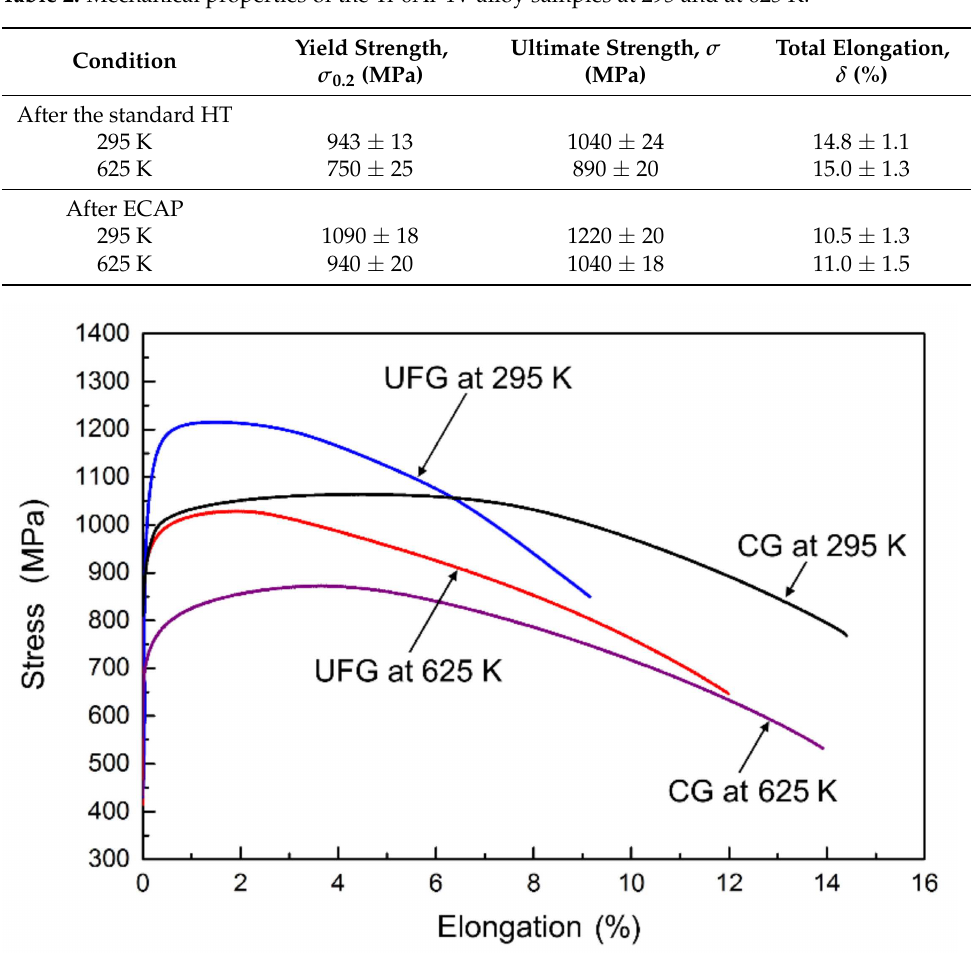
Figure 4. Tensile curves for the Ti-6Al-4V alloy samples at room temperature and at 625